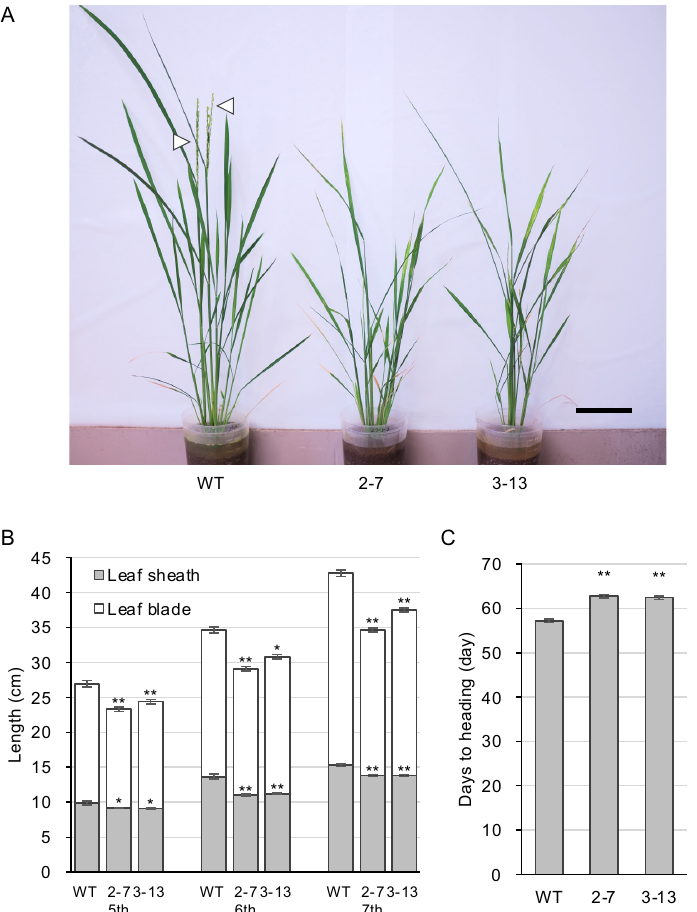
Figure 5. ugt74j1 mutants show mild stunting and delay in heading. ( A ) Growth of the ugt74j1 mutants. The image is of 60-d-old plants. White triangles indicate the headed spikes. The scale bar represents 10 cm. ( B ) The lengths of the leaf sheath and leaf blade in the mutants. The fifth to seventh leaves of 50-d-old plants were used. The data represent the mean ± SE ( n = 16). Asterisks indicate statistically significant differences compared with the wild type ( t -test, * p < 0.05, ** p < 0.01). ( C ) The heading dates of the mutants. The data represent the mean ± SE ( n = 15). Asterisks indicate statistically significant differences compared with the wild type ( t -test, ** p < 0.01).